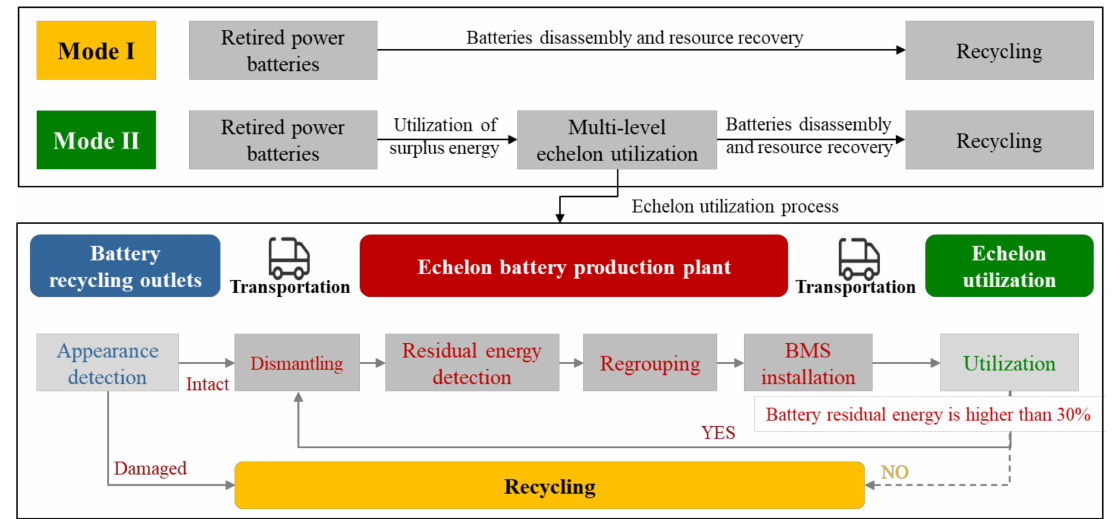
Figure 5. Main reusing modes and the echelon utilization process of retired power